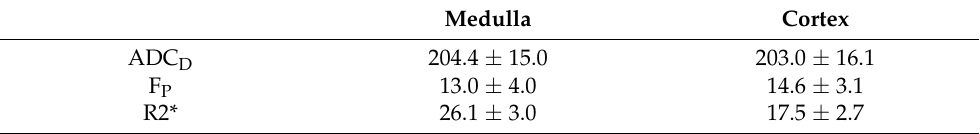
Table 2. Overall mean values and standard deviations of DWI- and BOLD-MRI-derived